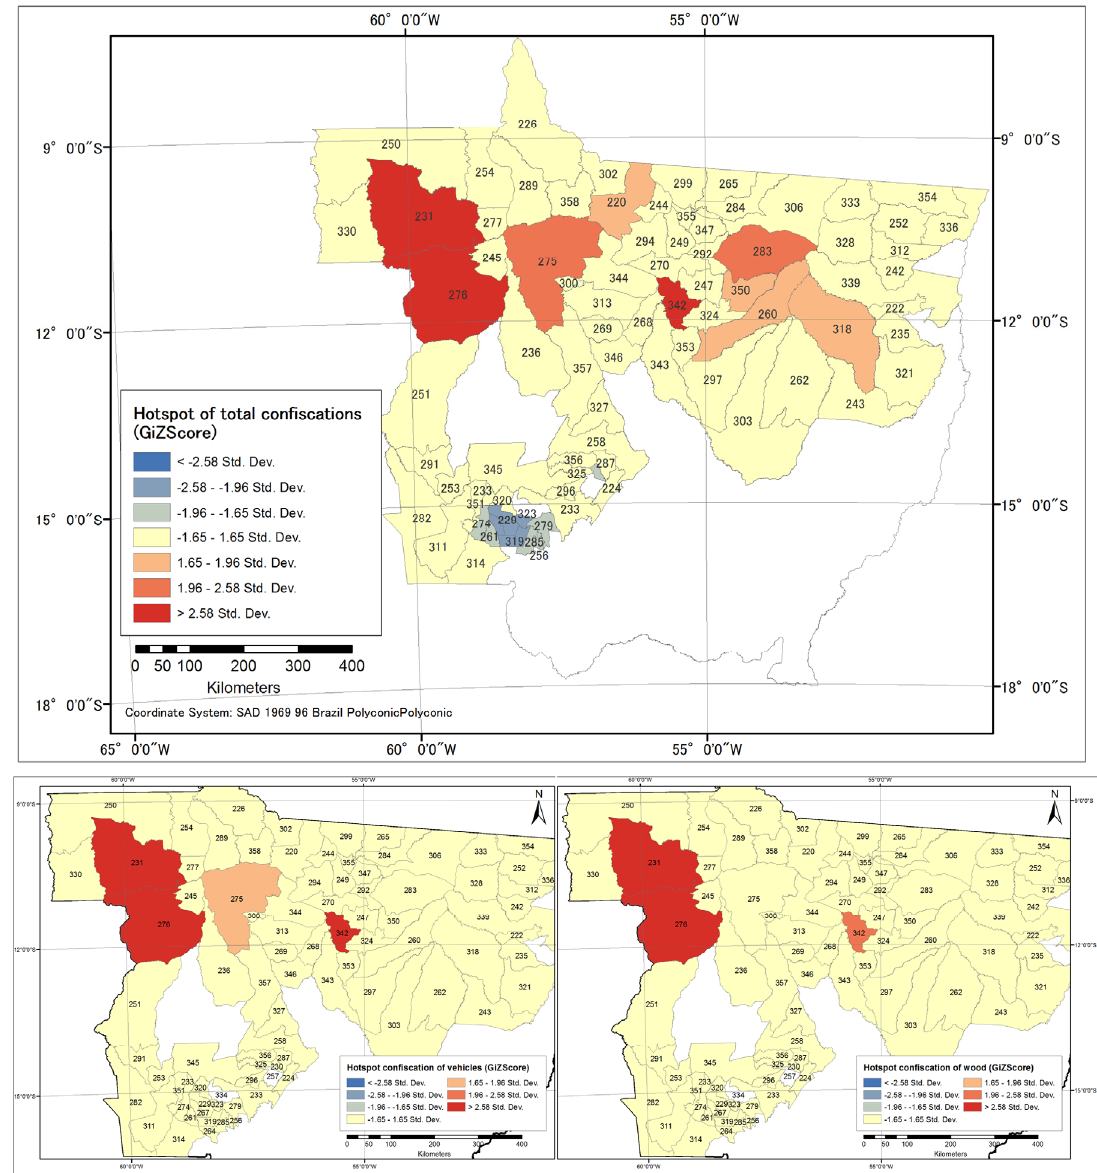
Figure 9. Hot spot analysis of confiscations.